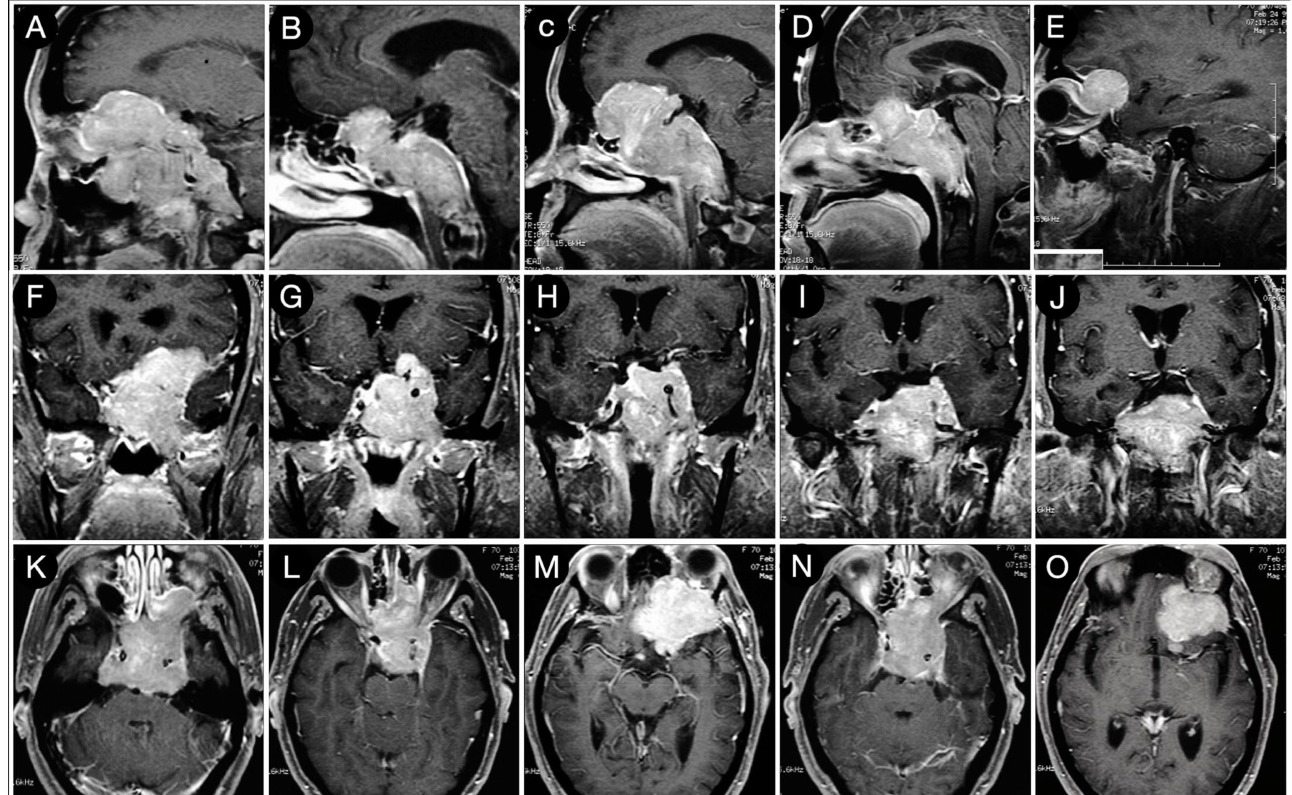
Figure 24. Preoperative sagittal ( A – E ), coronal ( F – J ), and axial ( K – O ) T1-weighted contrast-enhanced MRI. Scale bar: 5